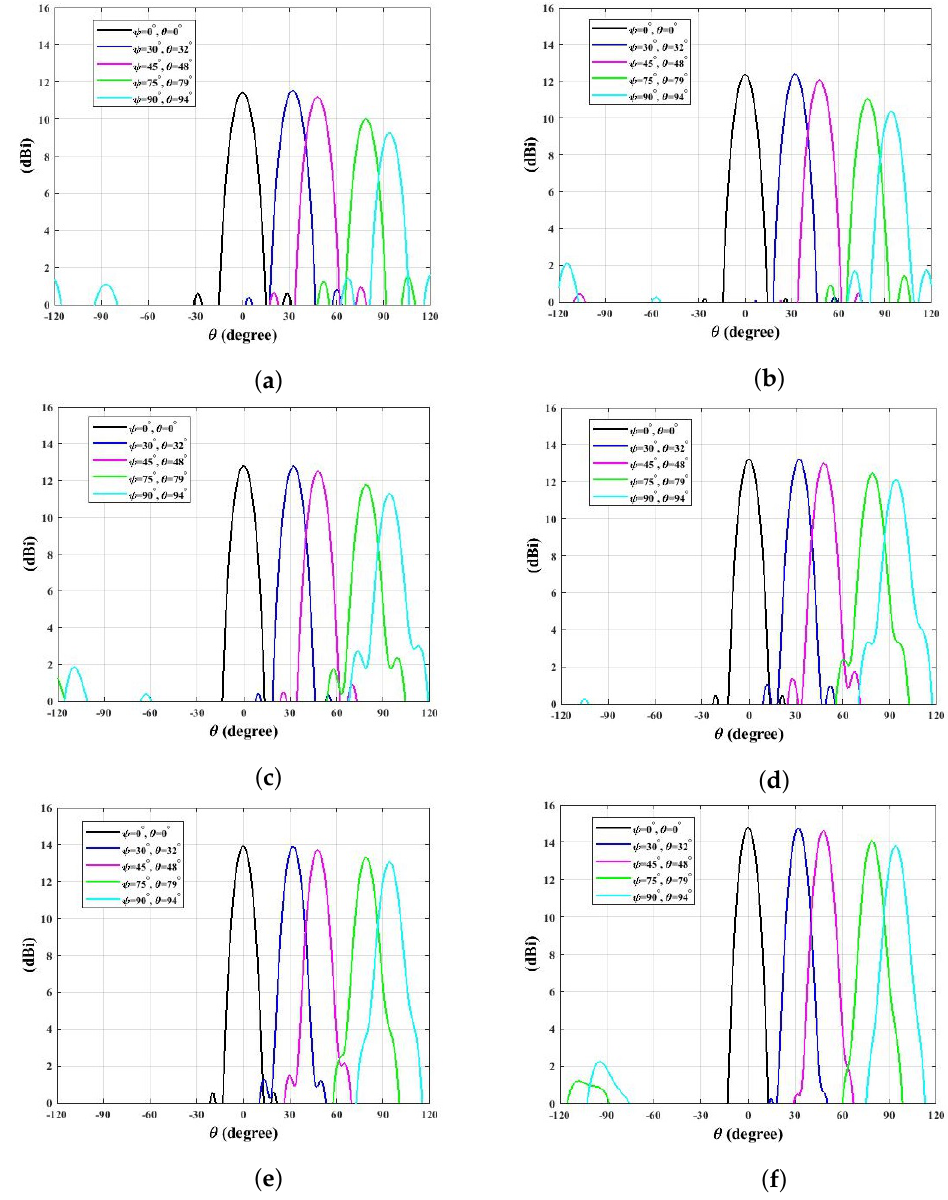
Figure 5. ( a – f ) Simulated steered radiated beam for circular rings pattern in 10 GHz, 11 GHz, 12 GHz, 13 GHz, 14 GHz and 15 GHz